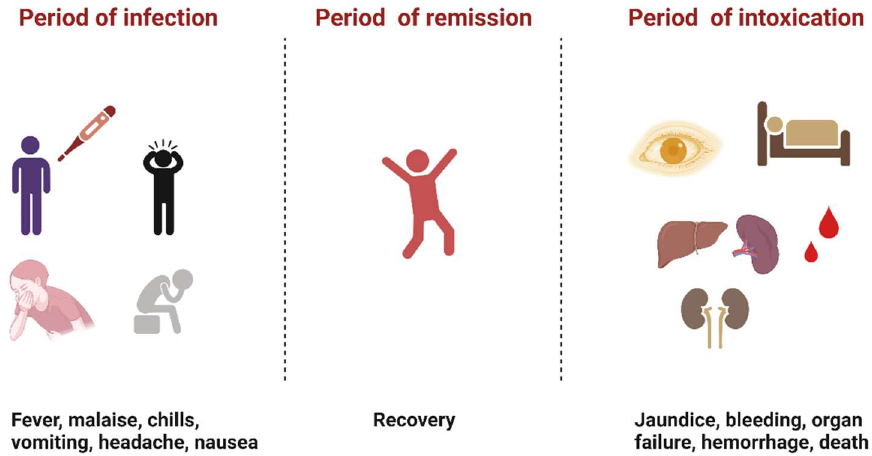
Figure 2. The three phases of severe yellow fever disease: period of infection characterized by non- specific symptoms, period of remission, where most individuals recover, and period of intoxication that occurs in extreme cases where individuals progress to a more severe form of the disease [12].